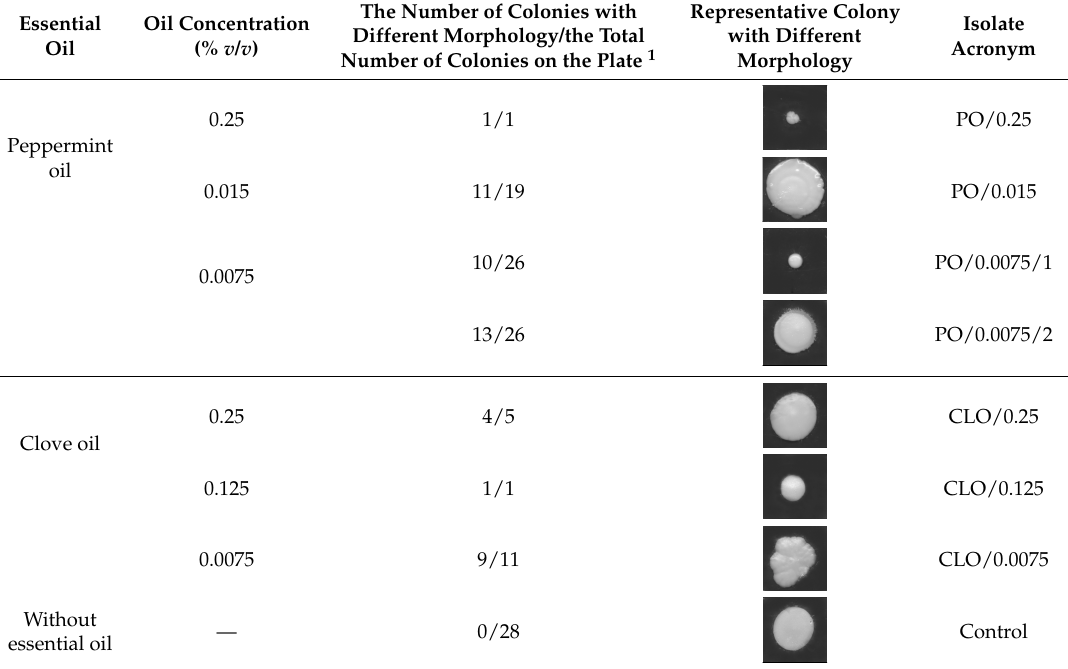
Table 1. Colony morphotypes of Candida albicans ATCC 10231 in the presence of peppermint oil (PO) and clove oil (CLO). Acronyms are composed as follows: essential oil type/oil concentration/isolate number (if any).